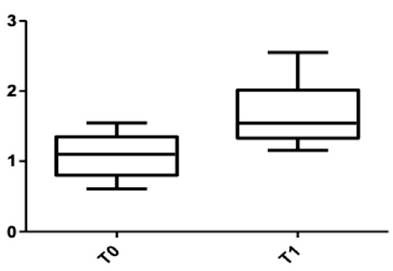
Figure 7. CBCT values at the cervical level, lower arch, at T0 and T1 for females.